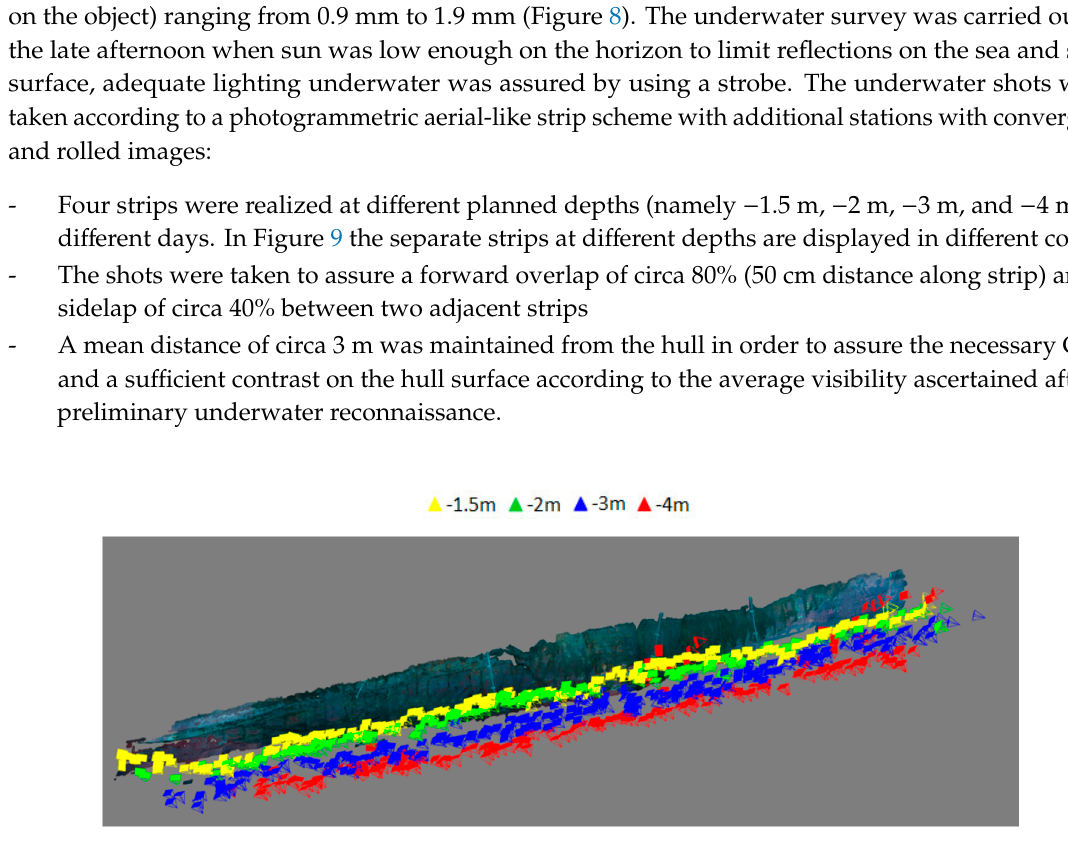
Figure 9. Camera network of the complete underwater survey made up of four different strips.